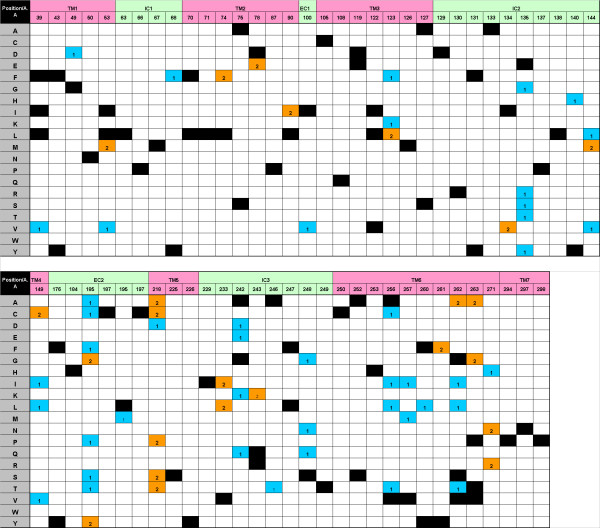
A SIFT matrix for the OR conservation core residues. Amino acid indicators (rows) for each of the 65 conservation core positions (columns) are colored if they were characterized by the SIFT algorithm as tolerant for class I ORs (blue), class II ORs (orange) or both classes (black).